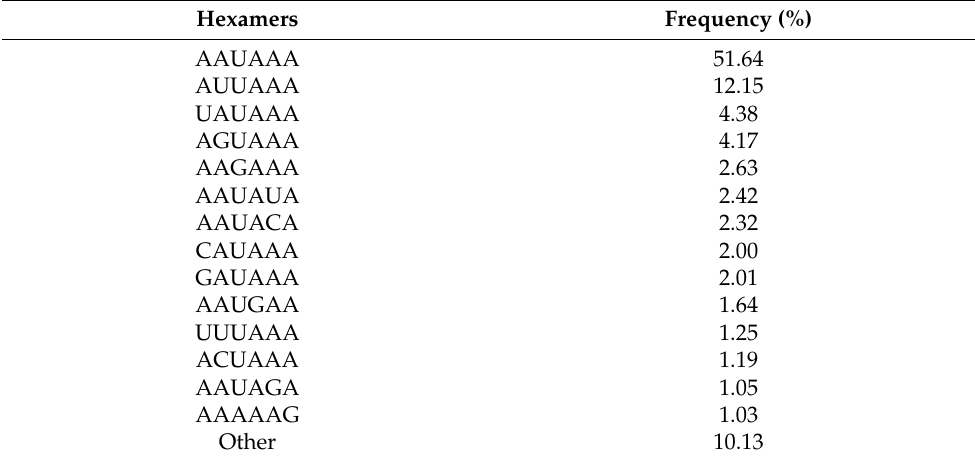
Table 2. Frequency (%) of hexamers